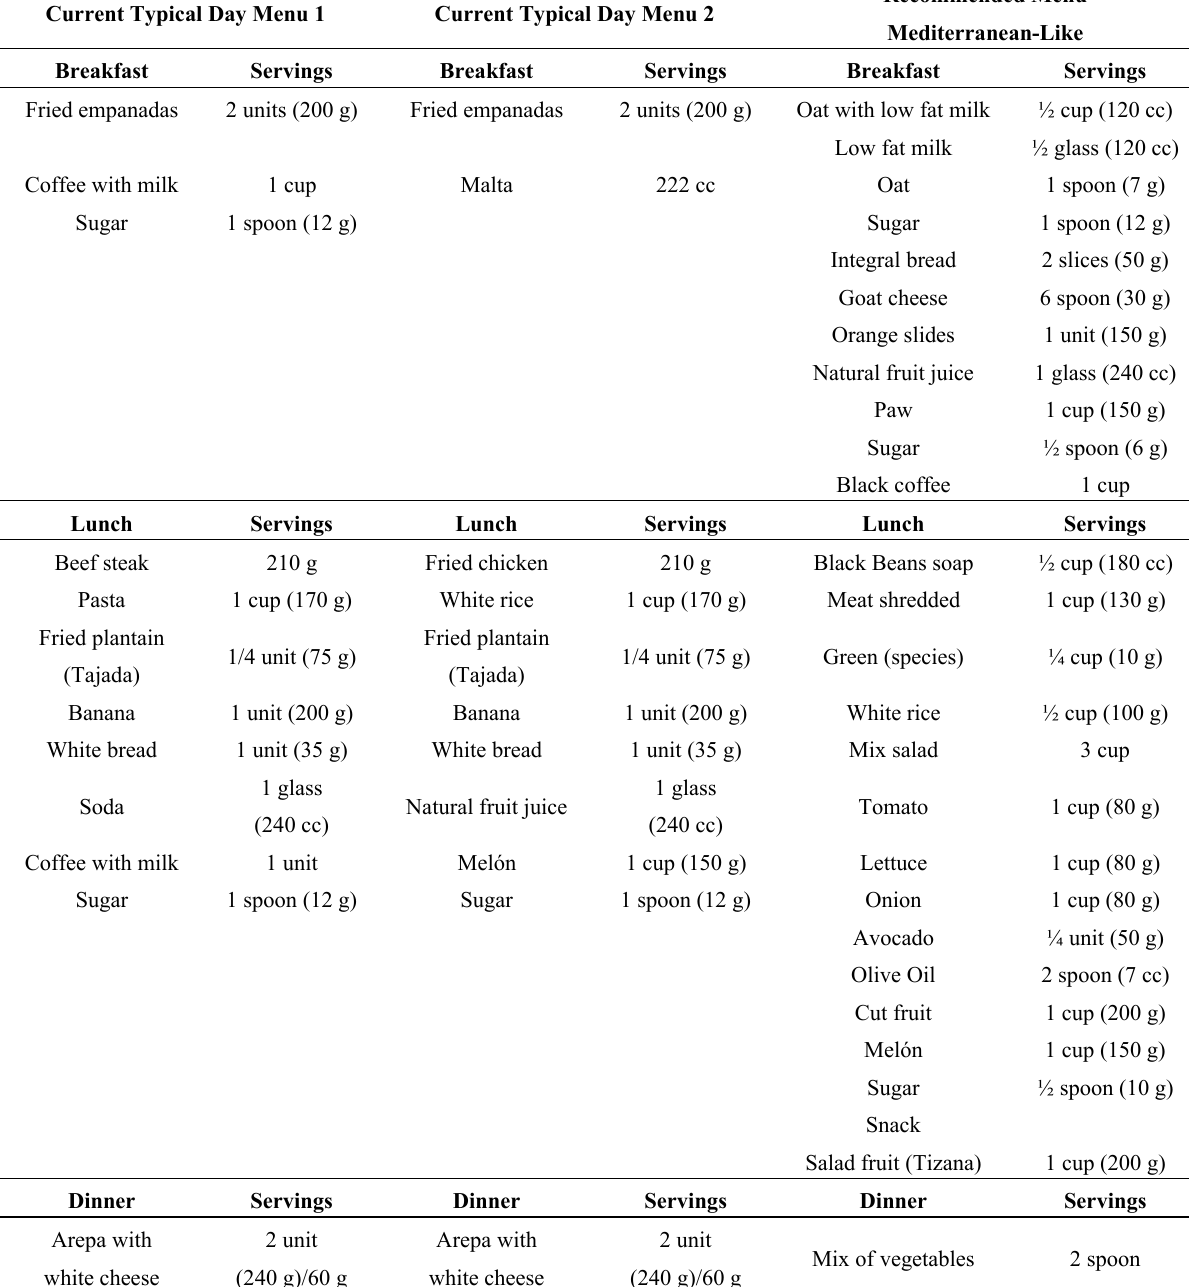
Table 2. Typical and recommended menus of Venezuelan